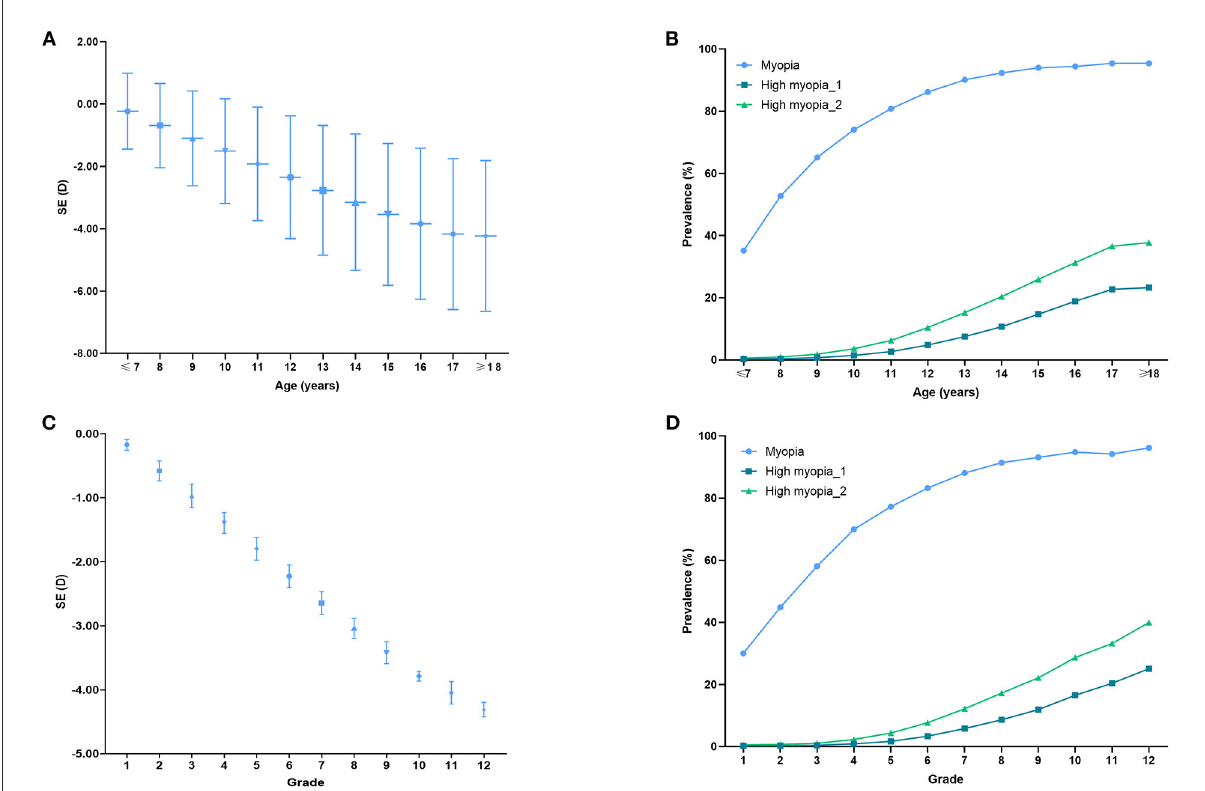
FIGURE2 Spherical equivalent (SE) distribution and myopia prevalence of different ages and grades. (A) SE distribution for school students by age. (B) Myopia prevalence for school students by age. (C) SE distribution for school students of different grades. (D) Myopia prevalence for school students of different grades. High myopia_1: SE ≤ − 6.00 D; High myopia_2: SE ≤ − 5.00